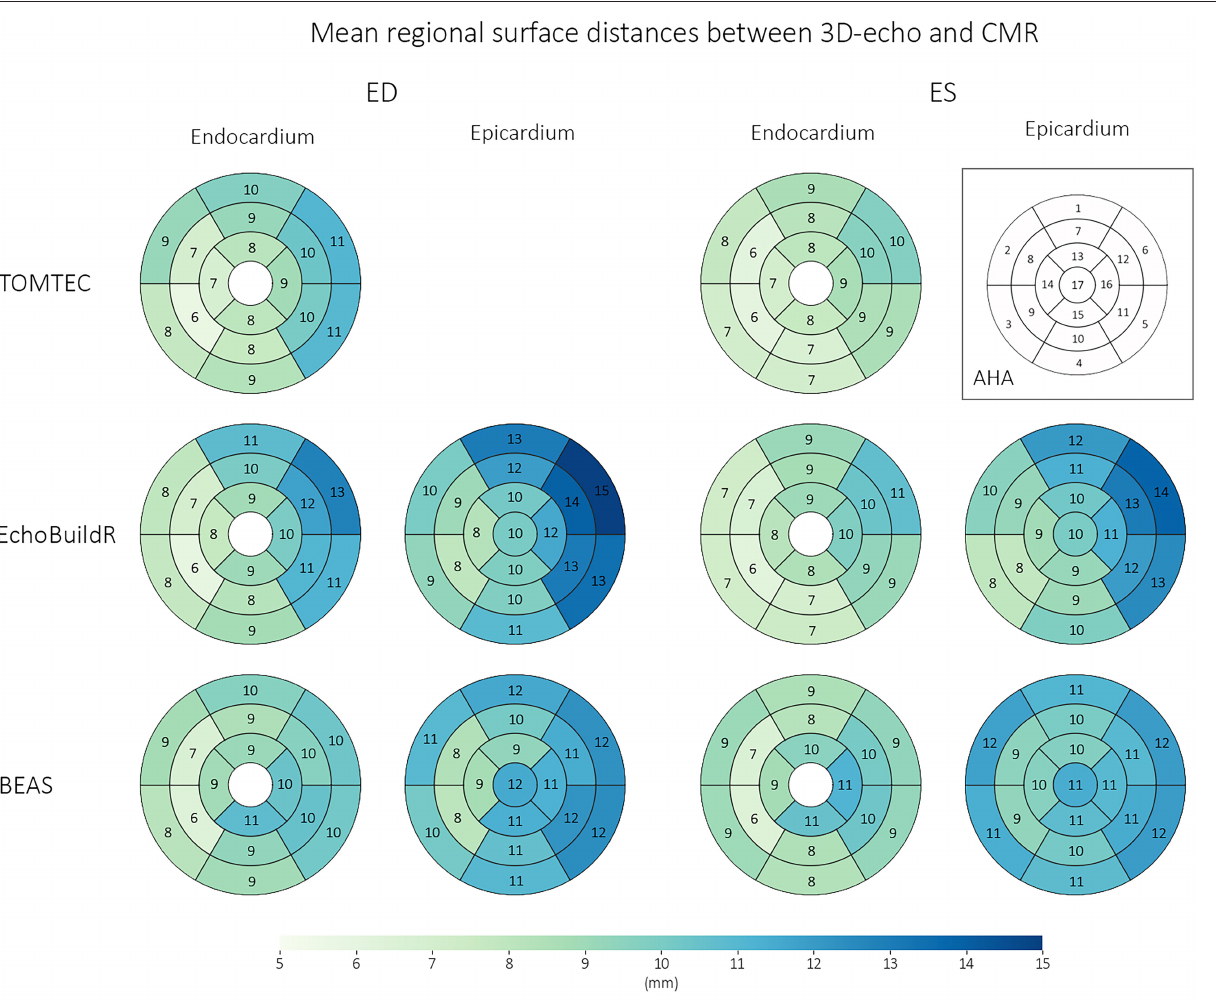
Frontiers in Cardiovascular Medicine |